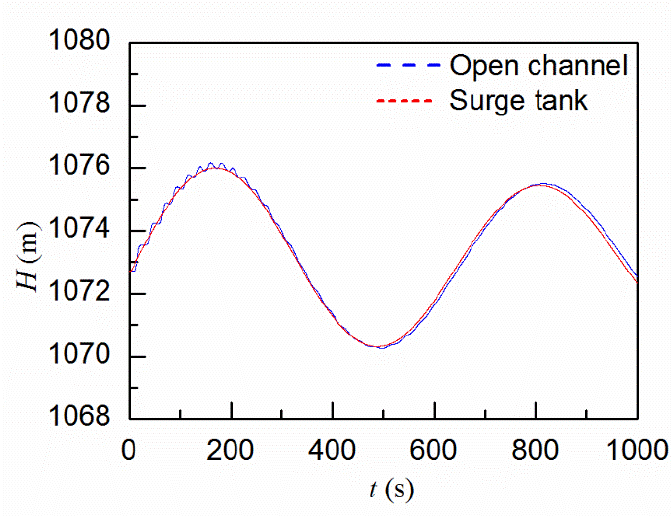
Figure 12. Comparison of the water levels in the sand basin with different modelling methods ( L 1 = 2400 m, h = 10 m, w = 10 m).